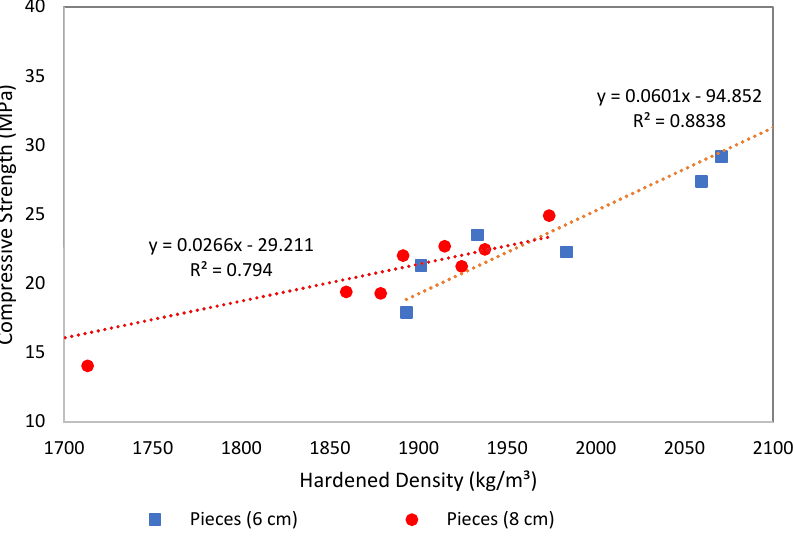
Figure 11. Correlation between compressive strength and the hardened density of the pieces for interlocking paving.